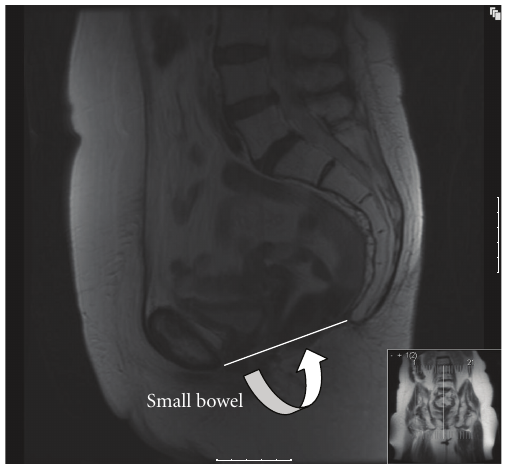
Figure 2: T 2 -weighted saggital view. Patient in supine position performing a Valsalva. The modified pubococcygeal line is seen. The downward migration of the small bowel (curved arrow) below this line is < 1cm indicating an intact reconstructed pelvic